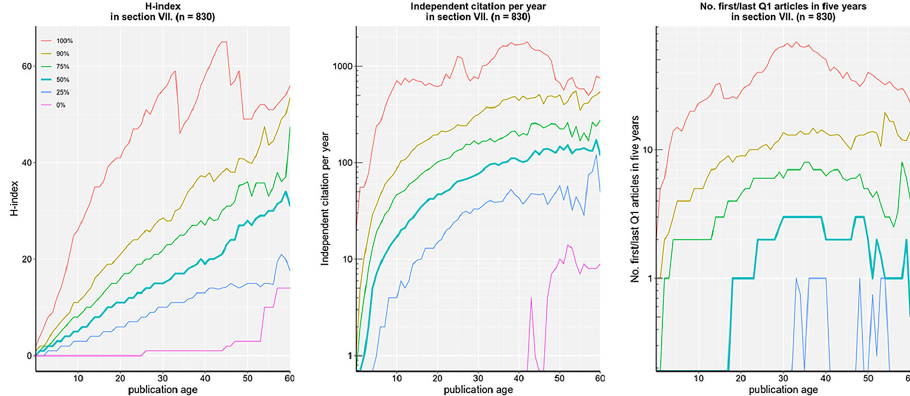
Note . The bold dark green line marks the median value. The red line shows the performance of the very best scientist in each year to date. In contrast to Figure 3 and 4 the Y-axis in logarithmic (except for